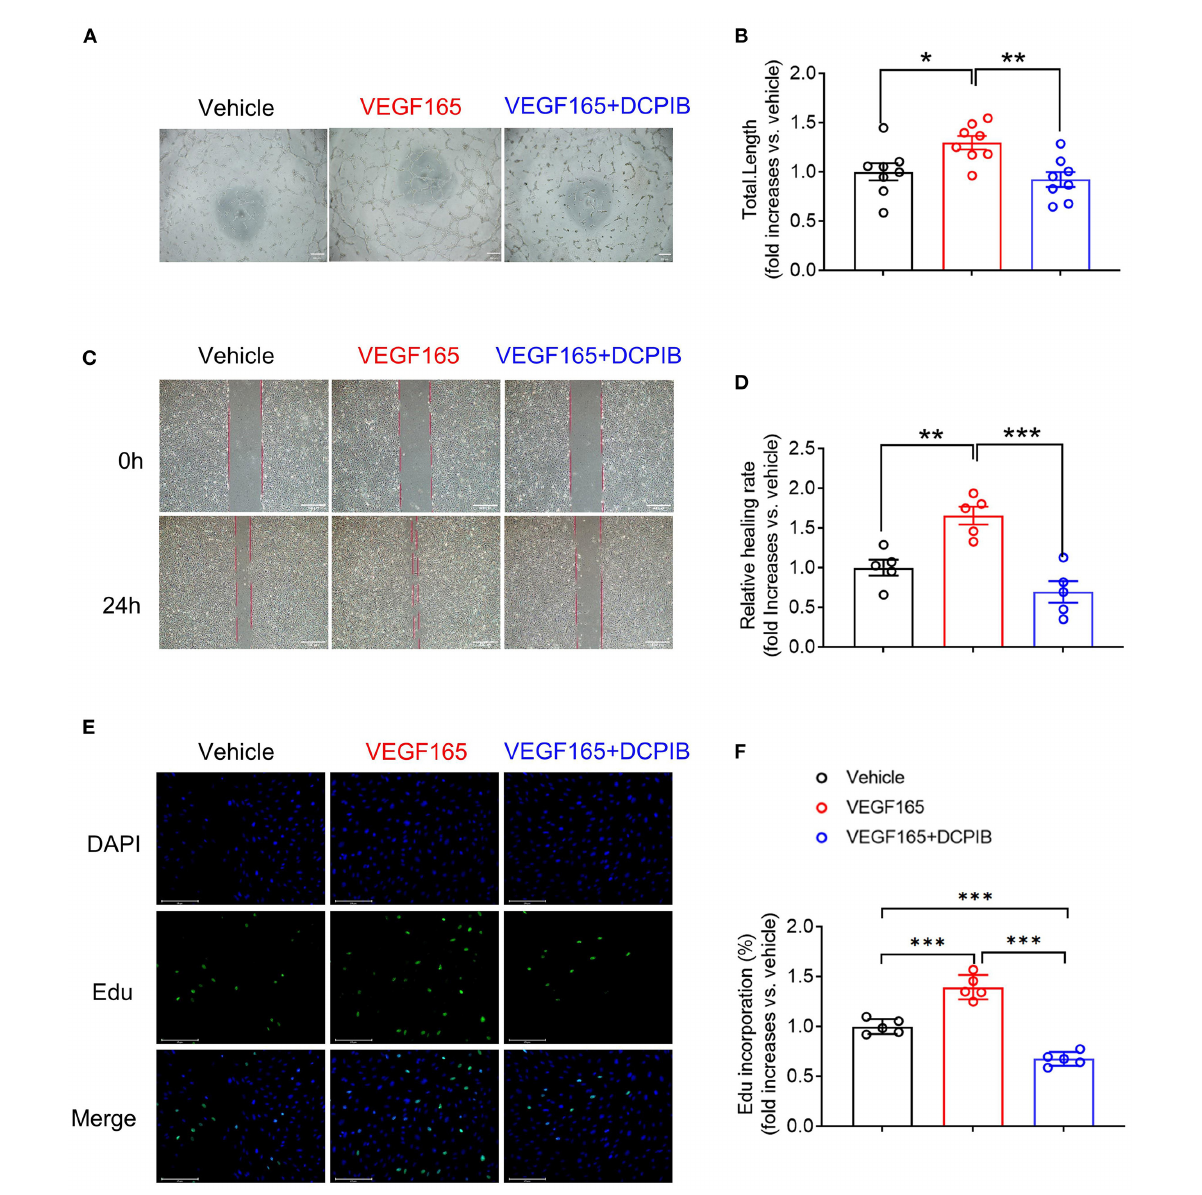
FIGURE4 DCPIB inhibited VEGF165-induced angiogenesis in vitro . (A,B) Representative images and quantitation of VEGF165 induced HUVECs tube formation in the presence or absence of 20 µ M DCPIB ( n = 8). (C,D) Representative images and quantitation of VEGF165 induced HUVECs migration assessed by wound healing assay in the presence or absence of DCPIB ( n = 5). (E,F) Representative images and quantitation of VEGF165 induced HUVECs proliferation evaluated by Edu staining in the presence or absence of DCPIB ( n = 5). Edu (Green), DAPI (blue). Scale bar = 100 µ m. * p < 0.05, ** p < 0.01, *** p < 0.001.